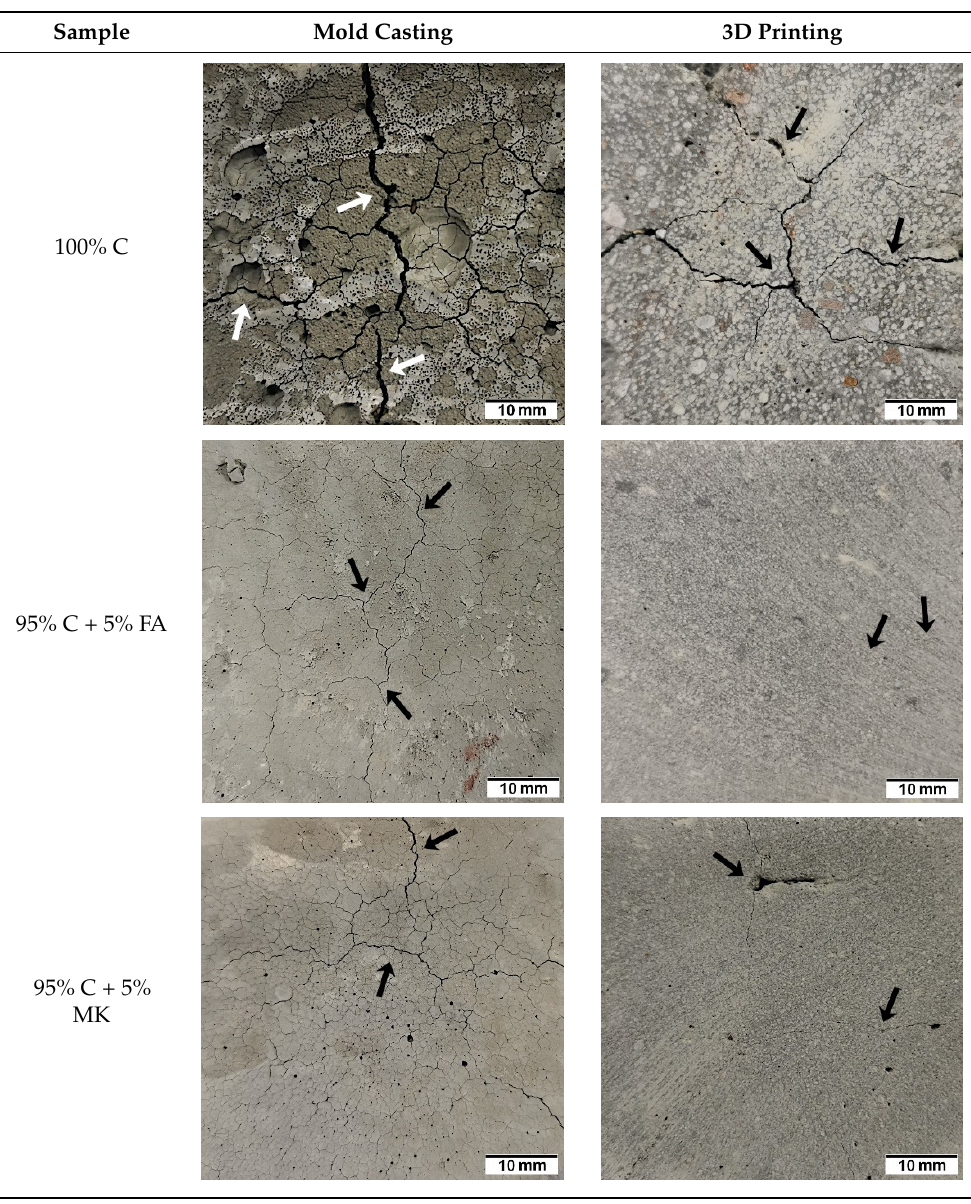
Table 5. The surface of the samples after the fire resistance test, depending on the method of their production (mold casting and 3D printing) and the composition of the mixture (100% C, 95% C + 5% FA, 95% C + 5% MK). The arrows indicate the cracks on the surface of the samples developed after fire resistance tests.